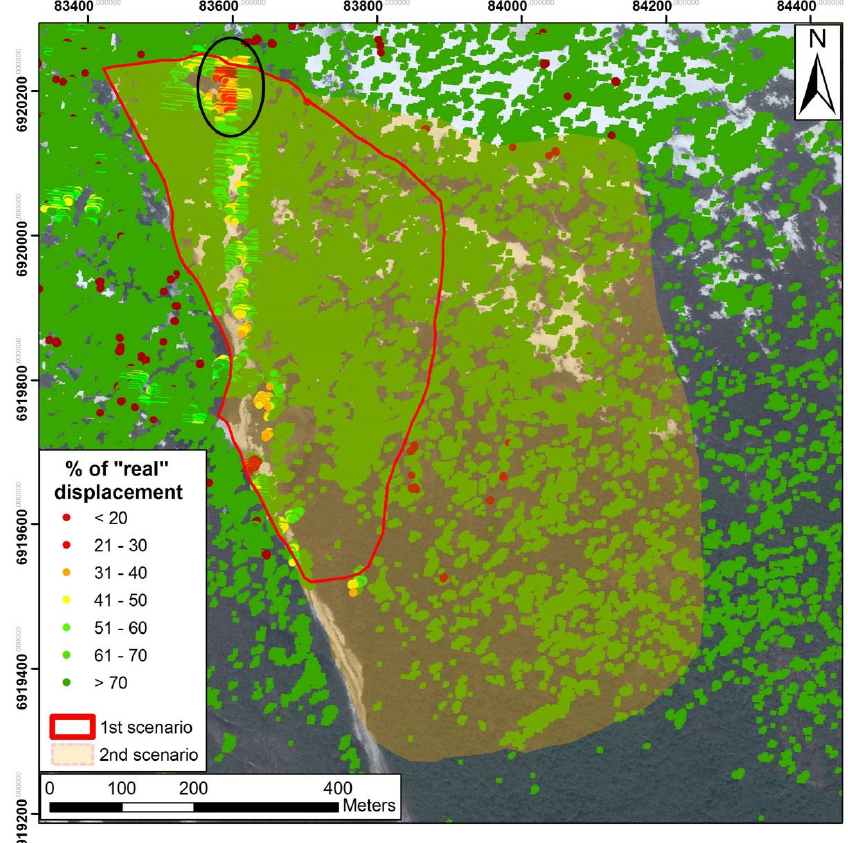
Figure 10. Map related to the % of “real” displacements detectable along the GB-InSAR LOS, considering as “real” the downslope direction. The sector emphasized by a black oval represents the upper part of the landslide, mainly concerning vertical movements.